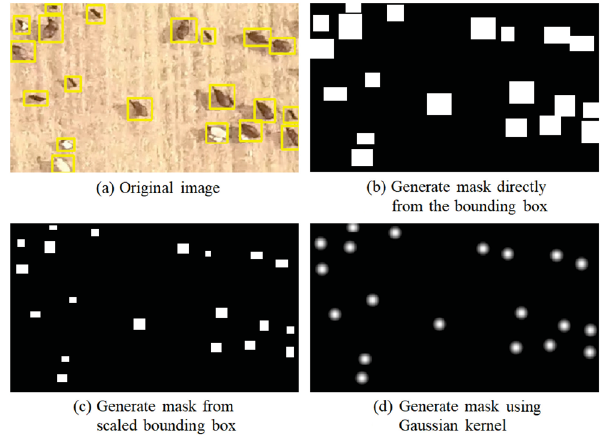
Fig. 5 Masks generated by three different